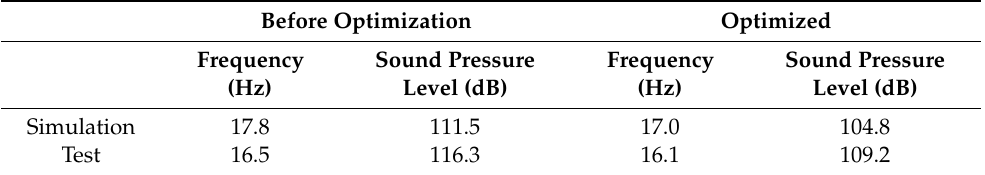
Figure 15. Sunroof buffeting noise test. ( a ) microphone. ( b ) test.lab noise test system. ( c ) the full opening skylight. Table 2. Comparison of sunroof buffeting noise results.